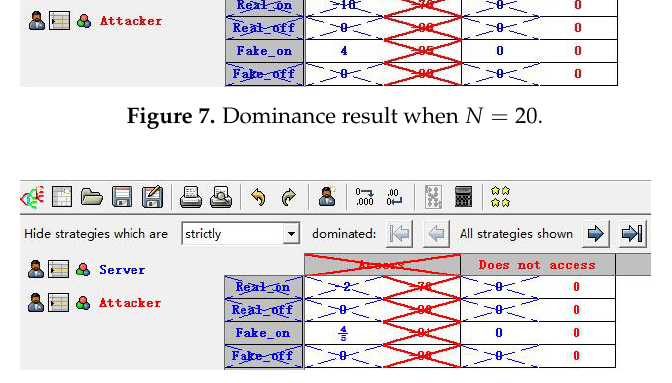
Figure 8. Dominance result when N = 100.